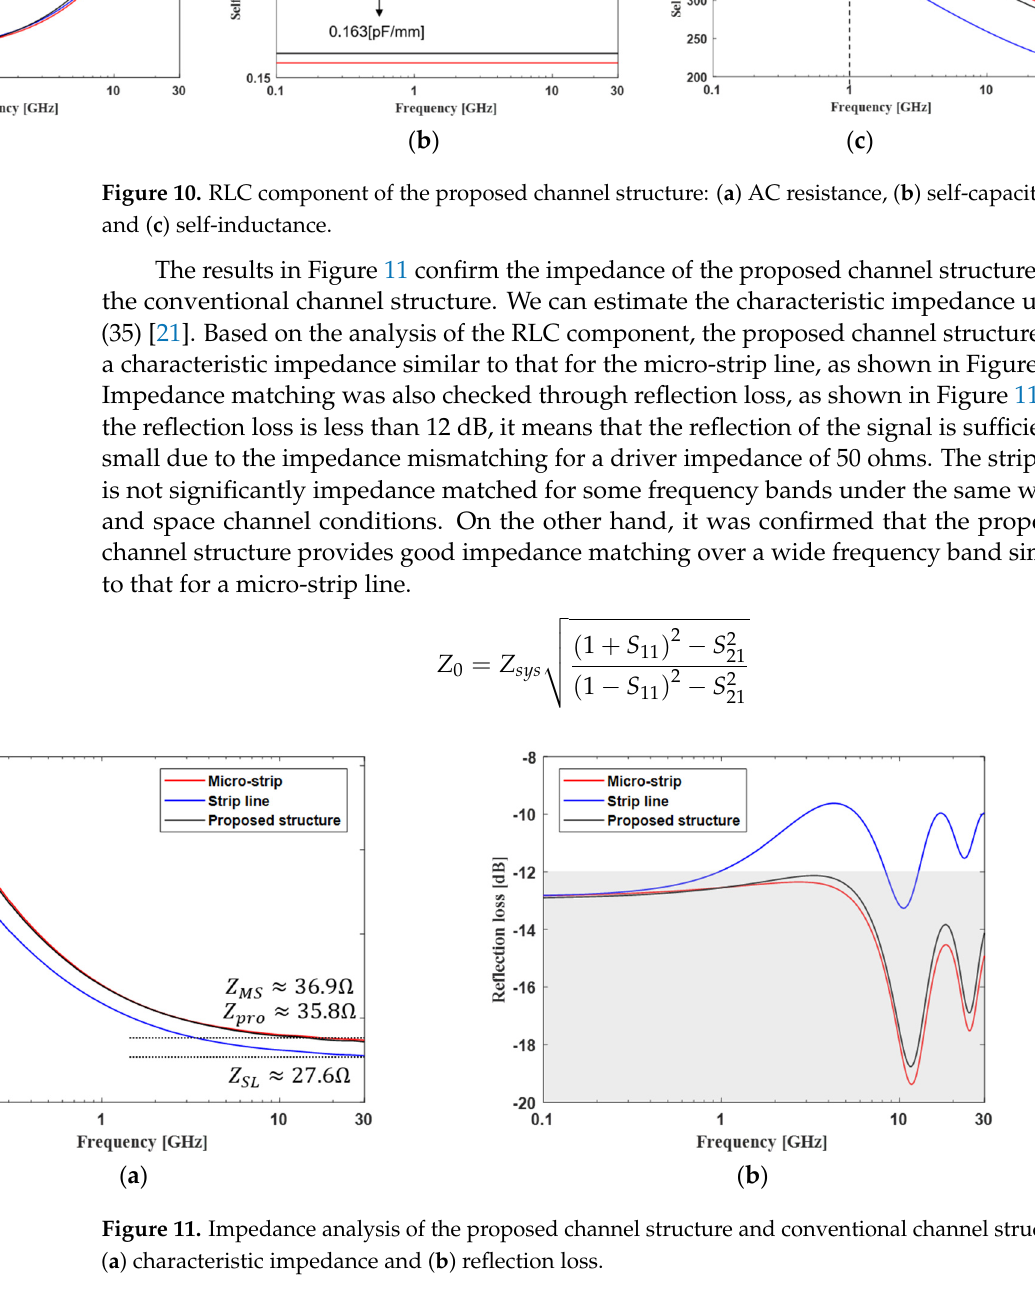
Figure 10. RLC component of the proposed channel structure: ( a ) AC resistance, ( b ) self-capacitance, and ( c ) self-inductance.